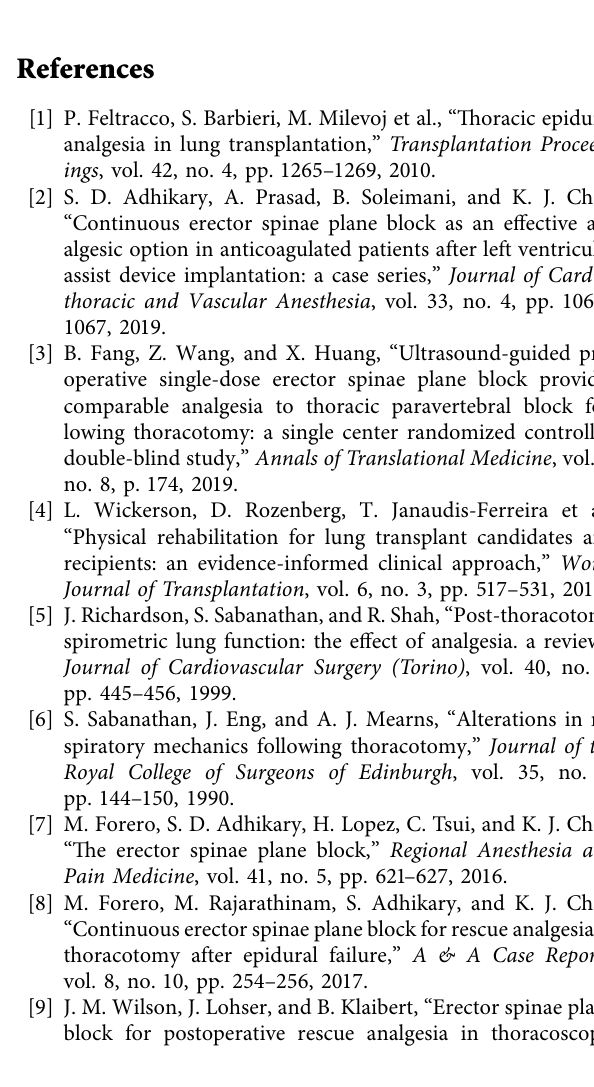
Figure 1: Postoperative pain scores, oxygen saturation, and intravenous hydromorphone consumption from extubation through recovery. ESP, erector spinae plane; IV,